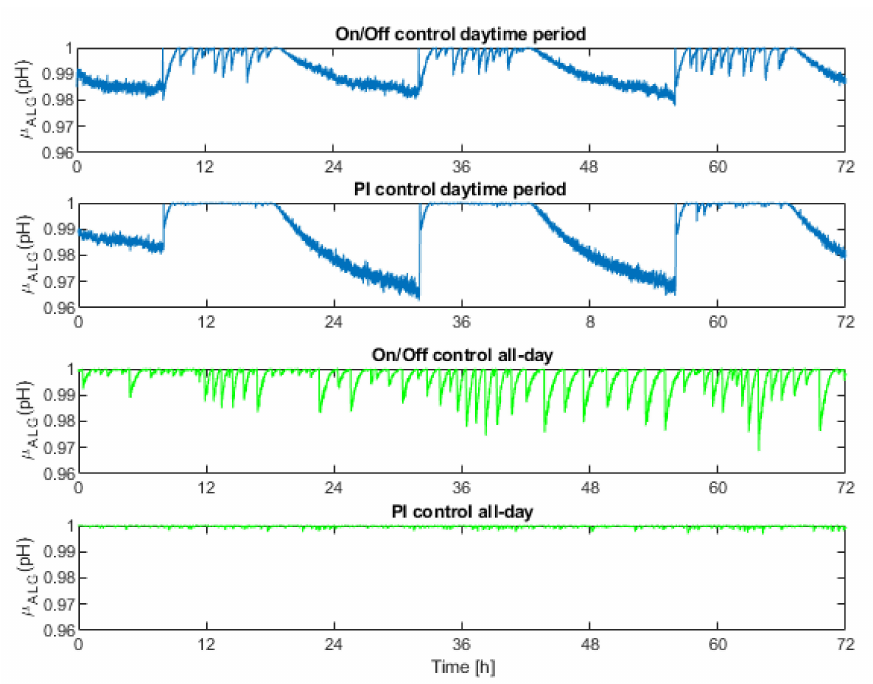
Figure 10. Results of the growth rate influenced by the pH in raceway reactors. First graph represents the evolution of this term with On/Off controller operated during daytime period. Second graph represents the evolution of this term with PI controller operated during daytime period. Third graph represents the evolution of this term with On/Off controller operated all-day. Fourth graph represents the evolution of this term with PI controller operated